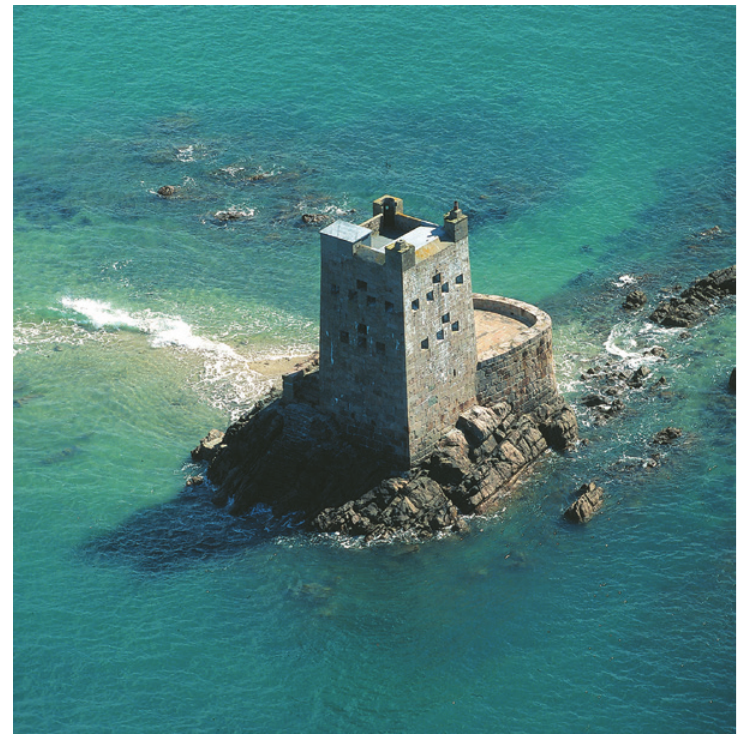
Figure 5 Seymour Tower, an eighteenth-century fortification near the Violet Bank, Channel Islands. (Image credit: Jersey Heritage)